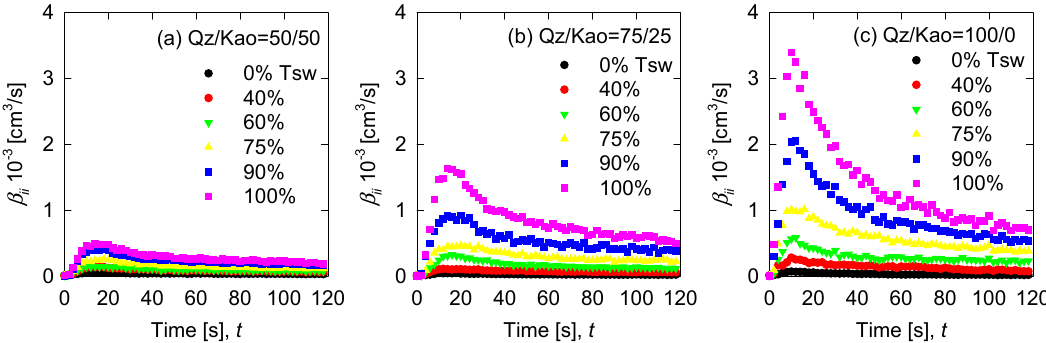
Figure 6. Collision frequency for the mean chord length over time. Quartz/Kaolinite ratio ( a ) 50/50; ( b ) 75/25; ( c ) 100/0.